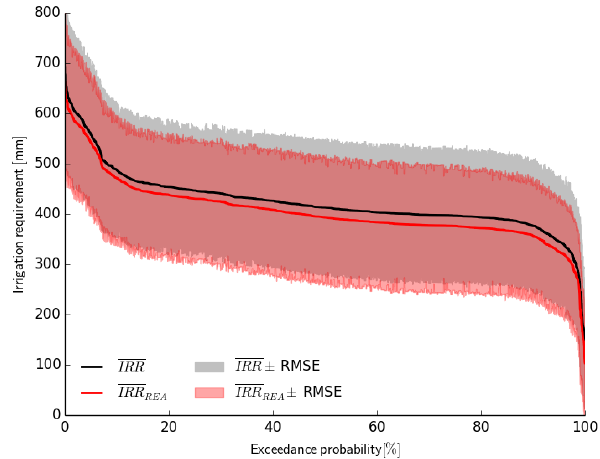
Figure 3. Exceedance probability of equally weighted average ir- rigation water requirement (IRR ) for wheat during the growing season. Averages have been calculated for each cropping area ( n = 3969 = 100%) for the period 1986–2006. Colours indicate different ET o methods (APET: areal potential evapotranspiration; PM56: FAO56 Penman–Monteith; HS: Hargreaves–Samani; PPET: point potential evapotranspiration; PT: Priestly–Taylor; TURC: Turc) and symbols differentiate K c sets.